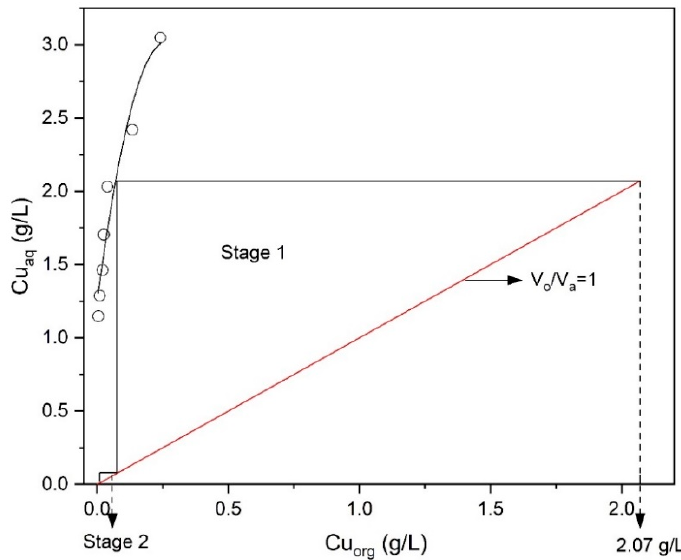
Figure 8. McCabe–Thiele diagram for extraction of Cu (Mextral 5640H = 10% ( v / v ), pH = 1.6, T = 25 °C, t = 10 min, rpm = 400).